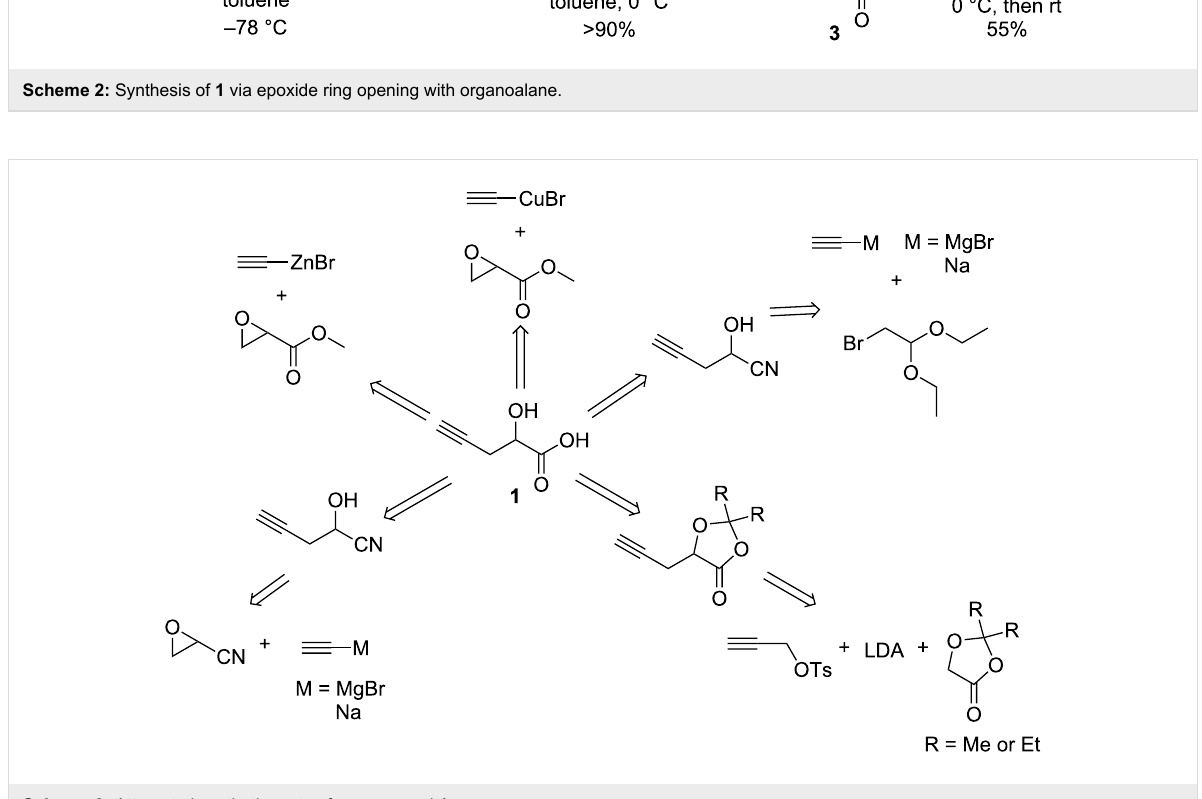
Scheme 3: Attempted synthetic routes for compound 1